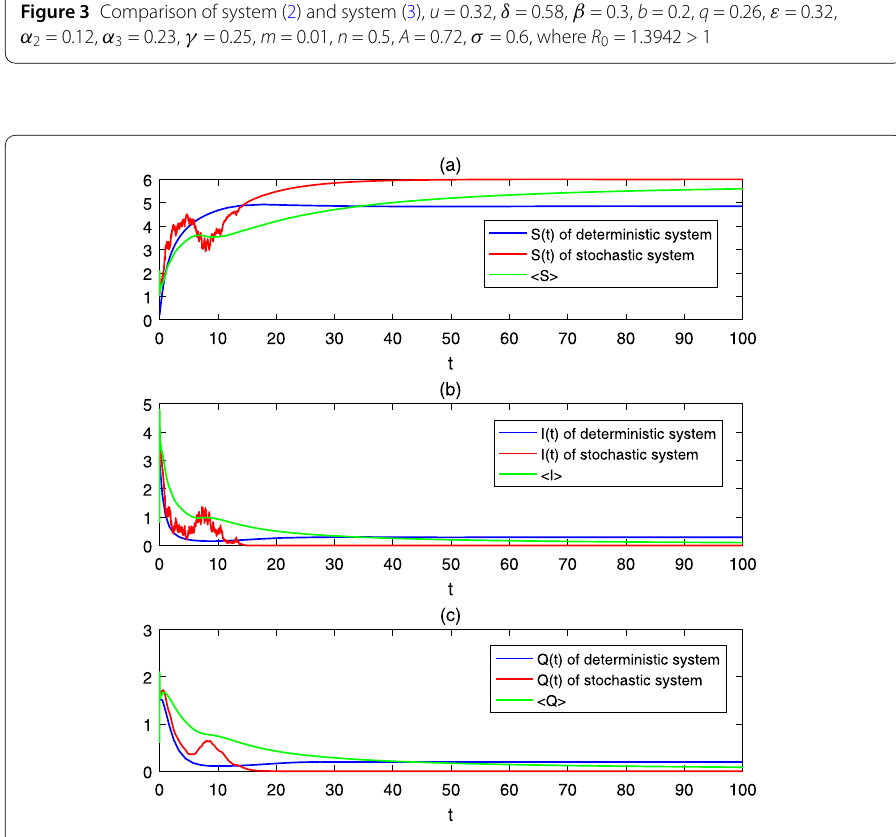
Figure 4 Comparison of system (2) and system (3), u = 0.32, δ = 0.58, β = 0.3, b = 0.2, q = 0.26, ε = 0.32, α 2 = 0.12, α 3 = 0.23, γ = 0.25, m = 0.01, n = 0.5, A = 0.72, σ = 0.21, where R 0 = 1.3942 > 1, (cid:23) R = 0.8141 <